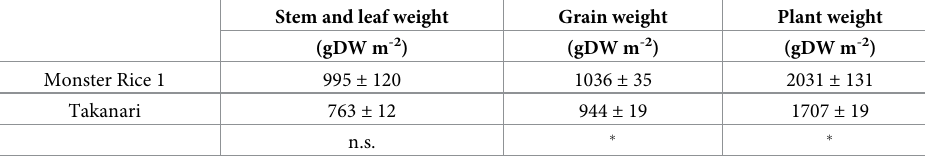
Table 1. Comparisons of biomass production between Monster Rice and Takanari in 2016. Stem and leaf weight Grain weight Plant weight (gDW m -2 ) (gDW m -2 ) (gDW m -2 ) Monster Rice 1 995 ± 120 1036 ± 35 2031 ± 131 Takanari 763 ± 12 944 ± 19 1707 ± 19 n.s. � � Mean ± SD (n = 3). Asterisks indicate significant difference between cultivars: n.s. indicates no difference and � indicates P < 0.05